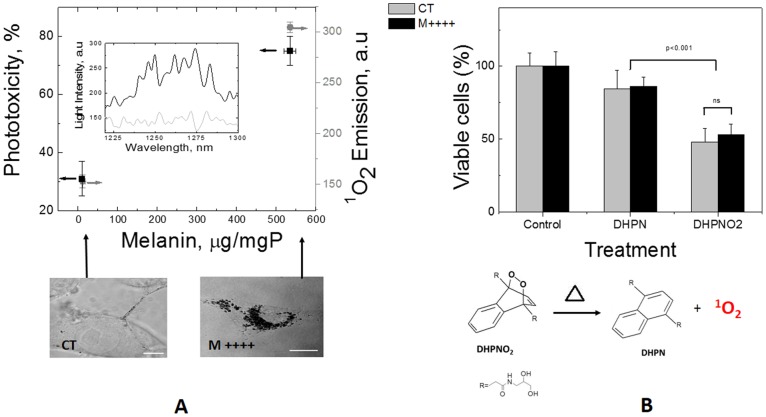
The effects of singlet oxygen on cells.(A) Phototoxicity and integrated emission spectra of the 1O2 that was generated upon excitation at 532 nm as a function of intracellular melanin production (in µg melanin/mg of total protein, squares) in B16-F10 CT or M++++ cells. Insert: 1O2 emission spectra from B16-F10 (CT and M++++) cells. The excitation wavelength was 532 nm 5-ns laser pulses at 10 pulses/s and 1 mJ/pulse. (B) Chemical generation of 1O2 by thermal degradation of DHPNO2 in CT and M++++ cells. The data are represented as the means±SD of three independent experiments, and the results are expressed as the percentage of viable cells compared with that in the control group. (*p<0.05 and ***p<0.001).